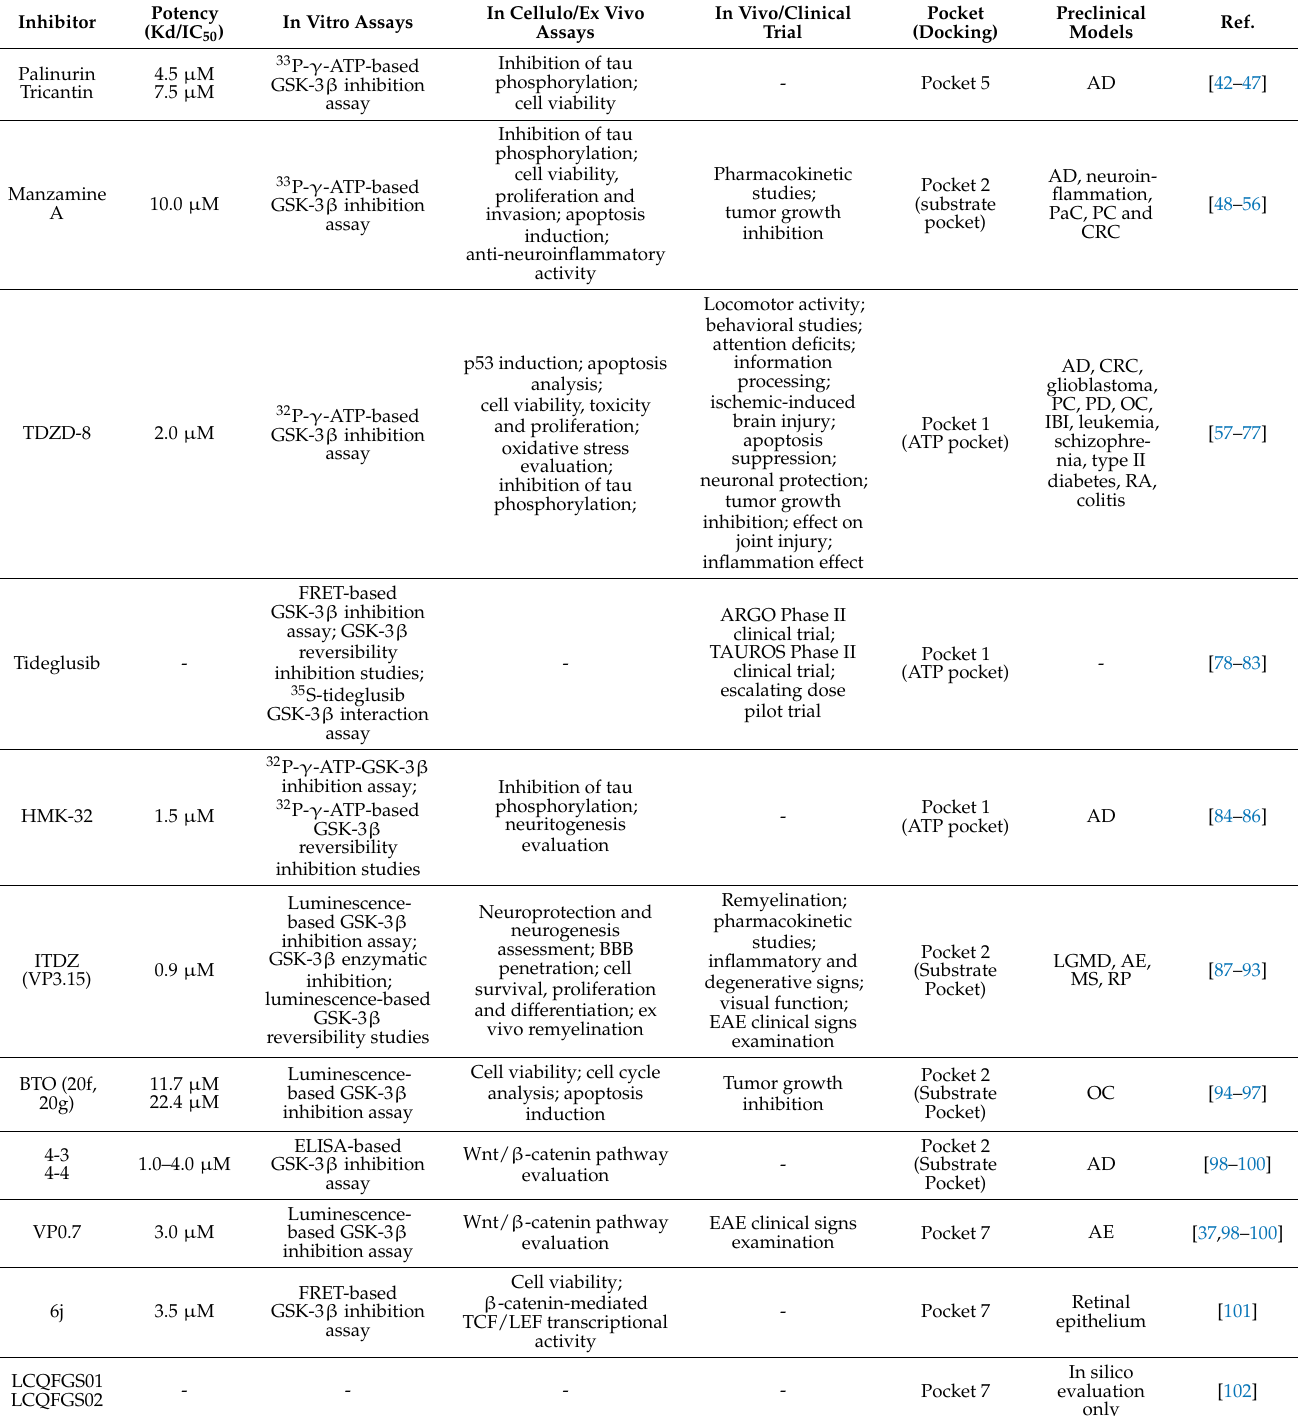
Table 2. Allosteric and non-ATP-competitive GSK-3 β